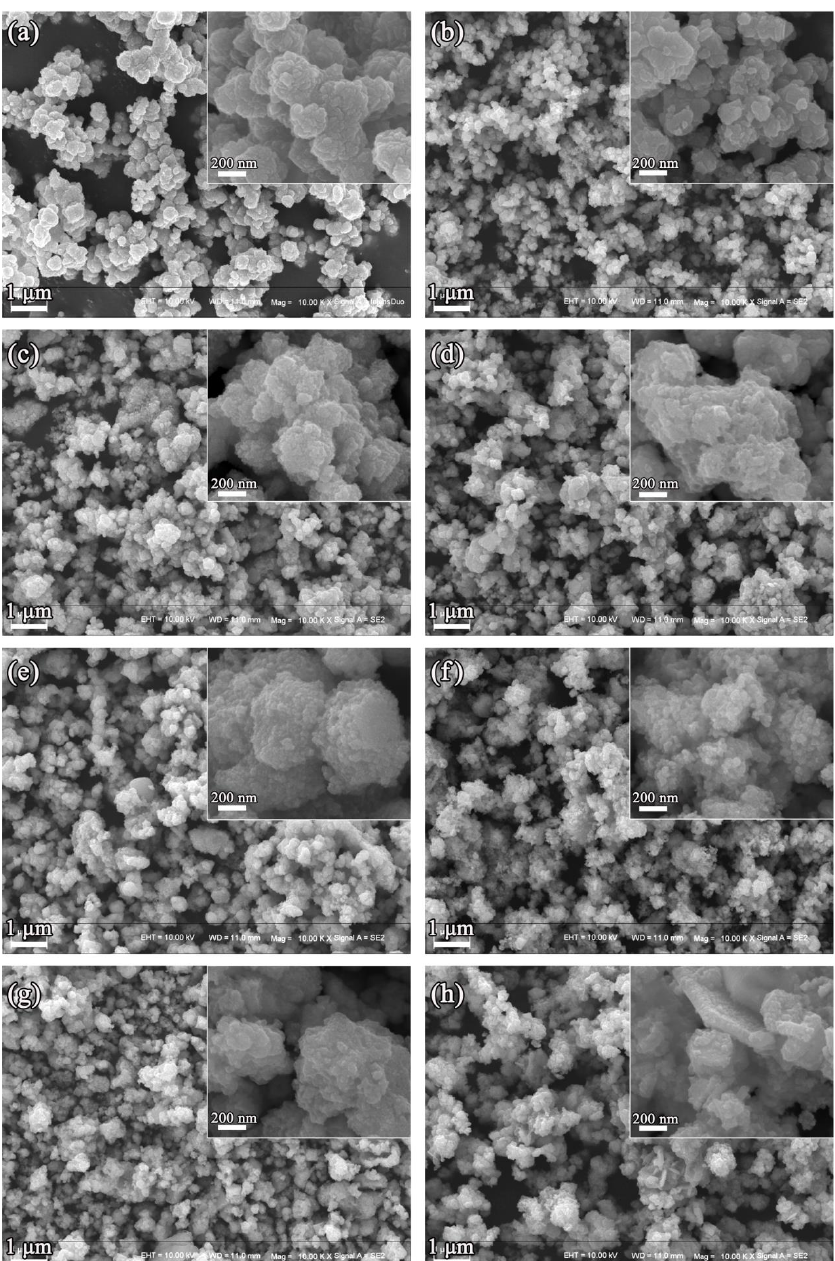
Figure 2. SEM images of CZTS nanoparticles obtained at ( a ) 0.5 h, ( b ) 1 h, ( c ) 2 h, ( d ) 3 h, ( e ) 5 h, ( f ) 8 h, ( g ) 12 h, and ( h ) 24 h.